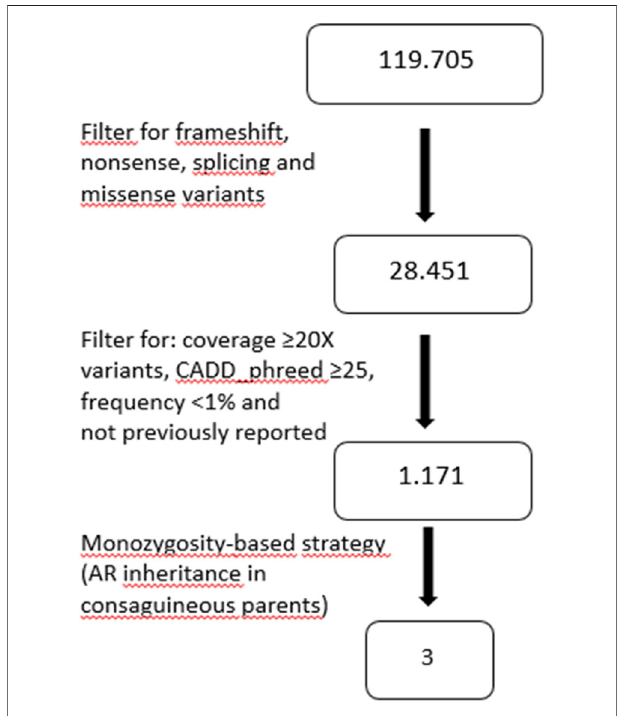
FIGURE 2 | Work fl ow diagram of variants ’ fi ltering in patient-parents trio